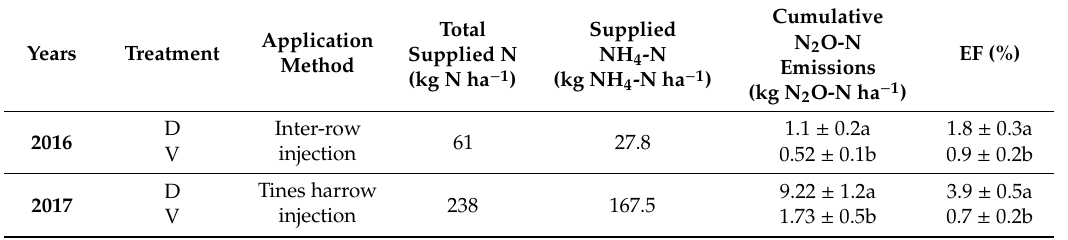
Table 2. The emission factors estimated for D and V in 2016 and in 2017. EF are determined as percentage of N applied subtracted by emissions measured under N0 (non-fertilized plot). Digestate injection (D) and digestate + inhibitor injection (V). ± standard deviations ( n = 3). Di ff erent letters indicate statistically significant di ff erences between the two means within year, according to the Tukey post-hoc test.